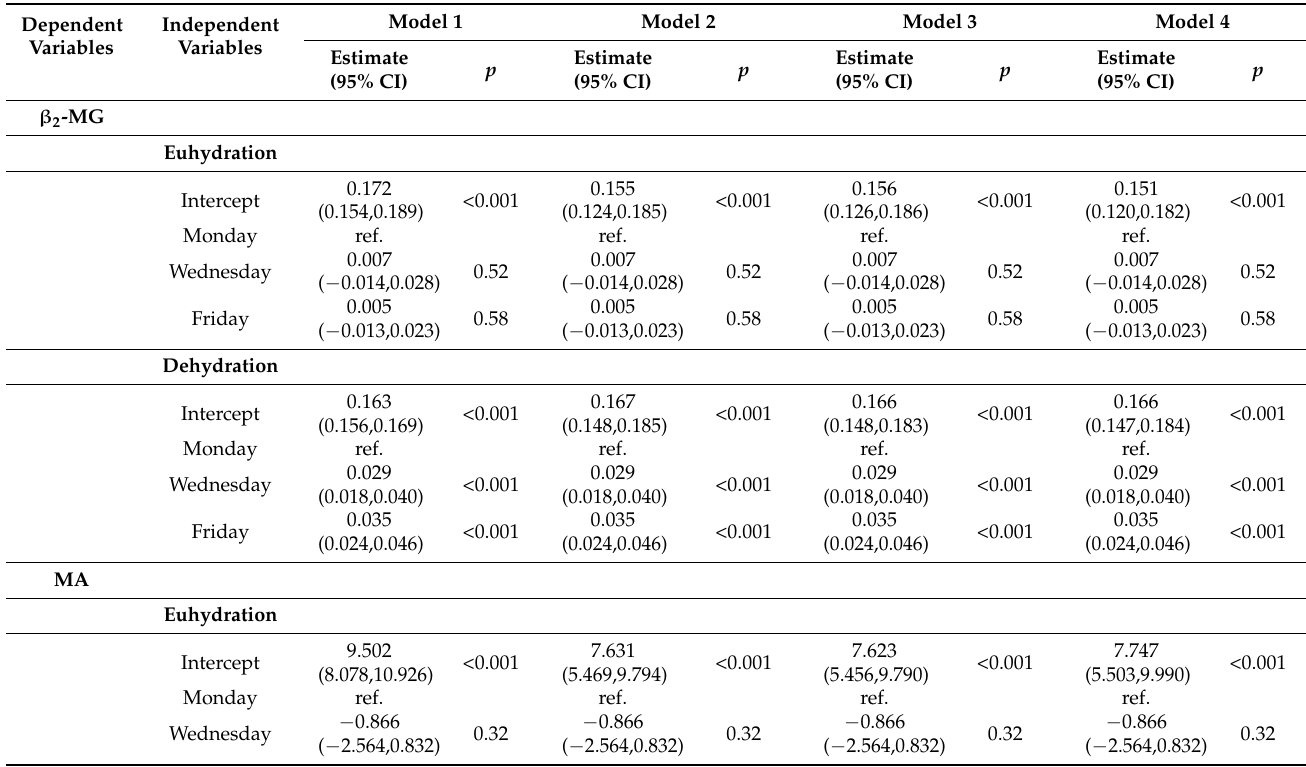
Table 2. Temporal changes of renal damage indicators within one week, grouped by hydration status among 7–8 years old children, Beijing,